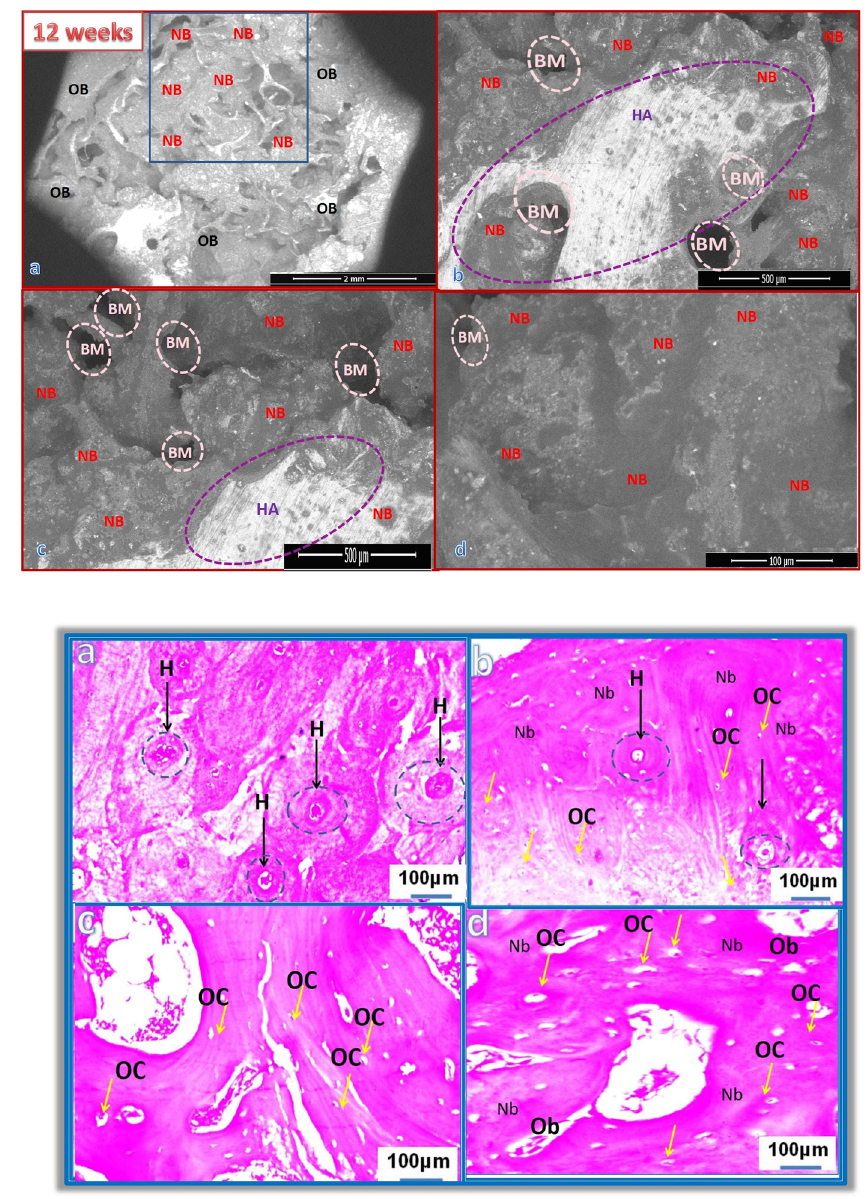
Fig. 9 SEM micrographs with different magni fi cations for a cross-section of bone defect drilled in the dog femur and grafted with bHA-coated Ti/Al alloy for 12 weeks post surgery: a at ×60 magni fi cation, b at ×200 magni fi cation, c at ×300 magni fi cation, and d at ×1200 magni fi cation